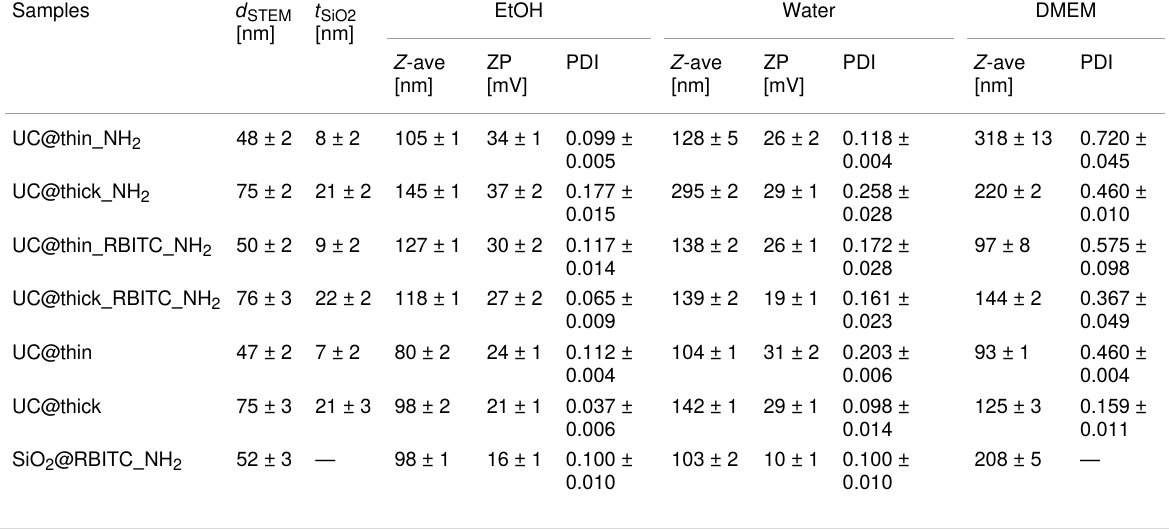
Table 1: STEM diameter, silica shell thickness as well as hydrodynamic diameter ( Z -average, Z -ave), polydispersity index, and zeta potential (ZP) values of silica-coated UCNPs in EtOH, water, and in supplemented DMEM complete medium.